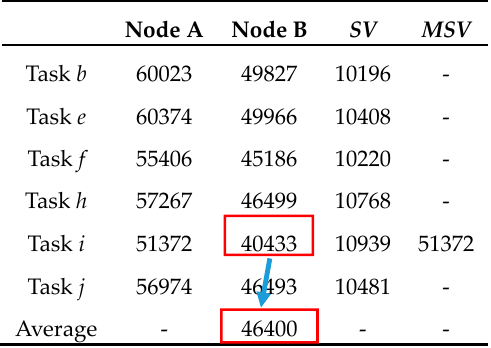
Table 10. Comparison of the average ECT values of tasks in Node D under Case 3.